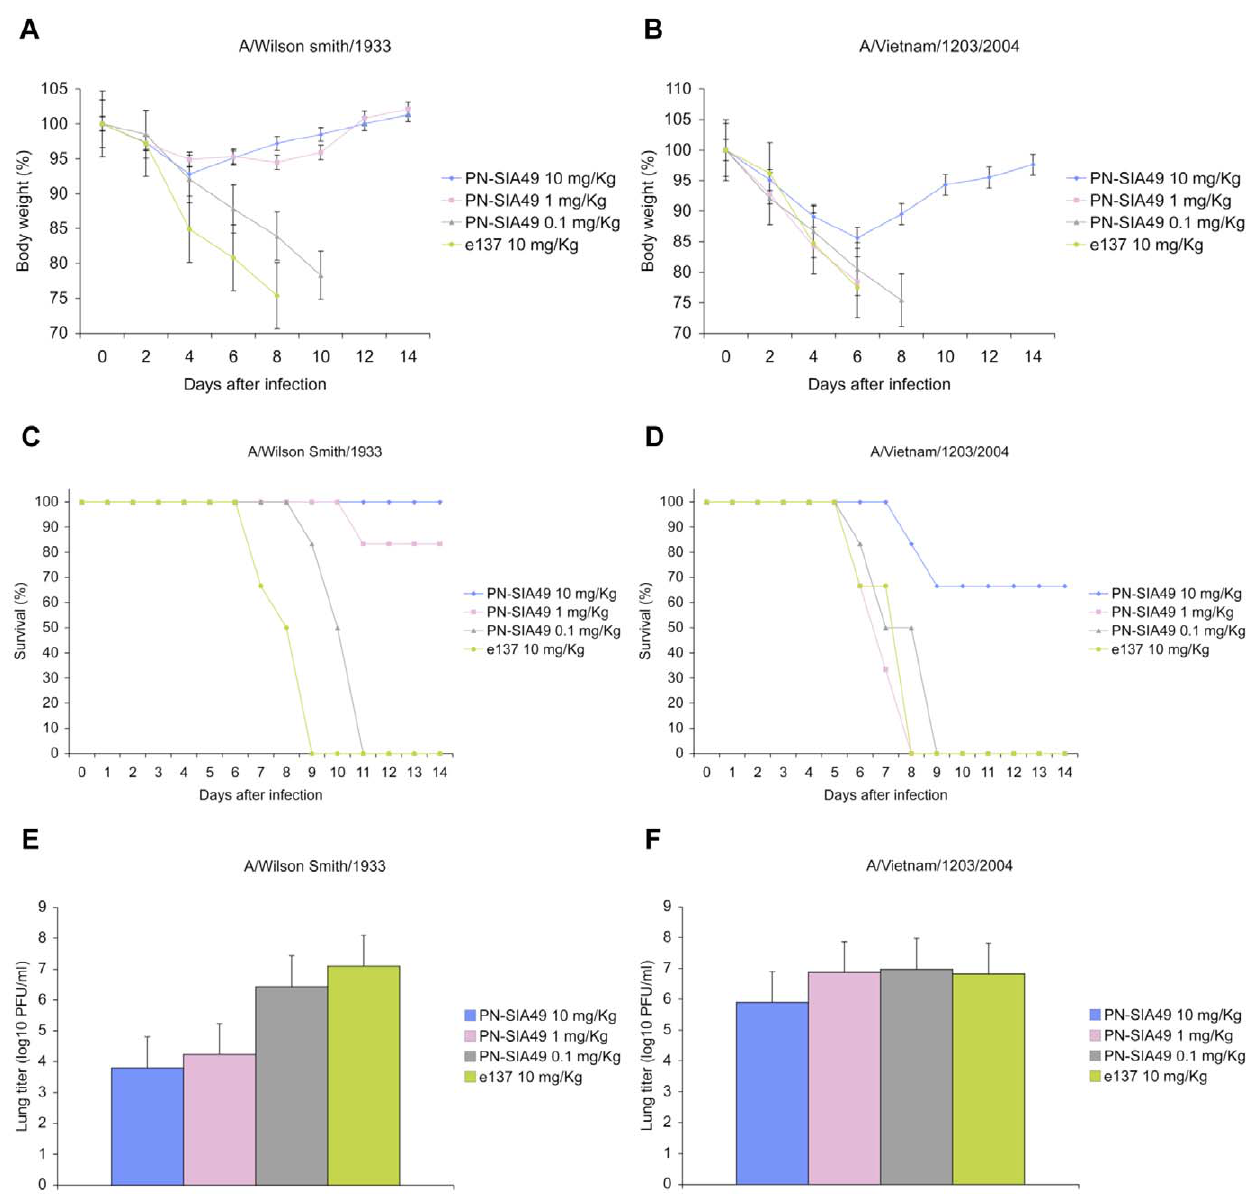
Figure 1. PN-SIA49 confers protection in mice against lethal challenge with both A/Wilson Smith/33 and A/Vietnam/1203/2004. Female BALB/c mice were challenged with 3 LD50 of A/Wilson Smith/33 (WS33) or A/Vietnam/1203/2004 (VN04). Twenty-four hours after the viral challenge, graded doses (10, 1, 0.1 mg/Kg) of PN-SIA49 or the control antibody (e137, 10 mg/Kg) were administrated to mice. Mice were monitored for body weight loss and survival for 2 weeks after challenge. (A) Body weight following WS33 virus challenge and (B) VN04 and treated with PN- SIA49. (C) Survival rates of mice challenged with WS33 and (D) VN04 after PN-SIA49 treatment. (E) Viral titers in the lungs of mice challenged with WS33 and (F) VN04 on day 4 post infection. Each data point represents the average viral titer from 4 mice. A group of mice treated with a negative control mAb (e137) was used and is included in each panel for direct comparison.